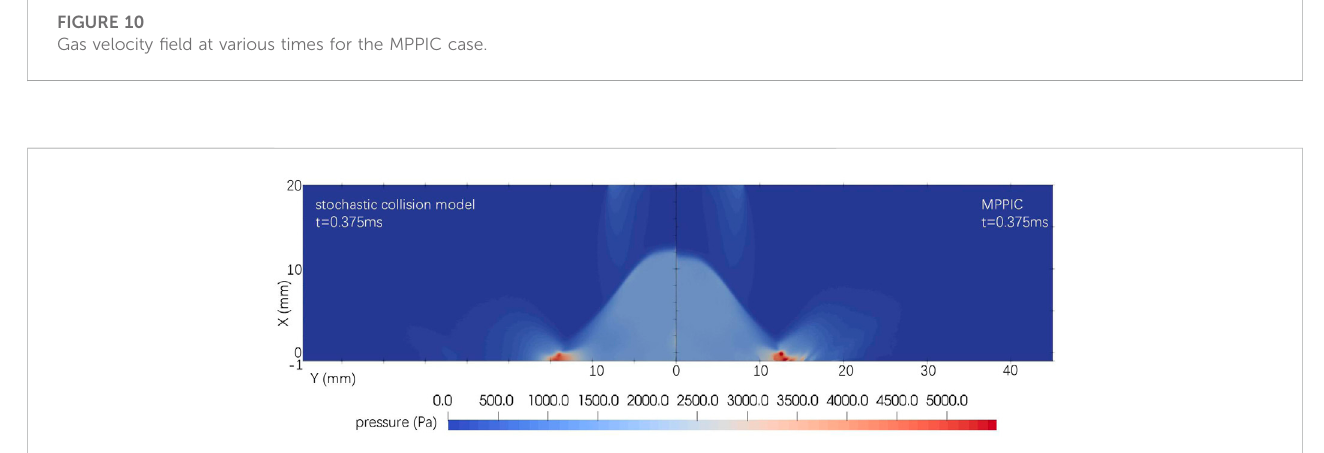
have been distorted because of the existence of the solid particles while the main shape of the radial velocity along the axis does not change much.